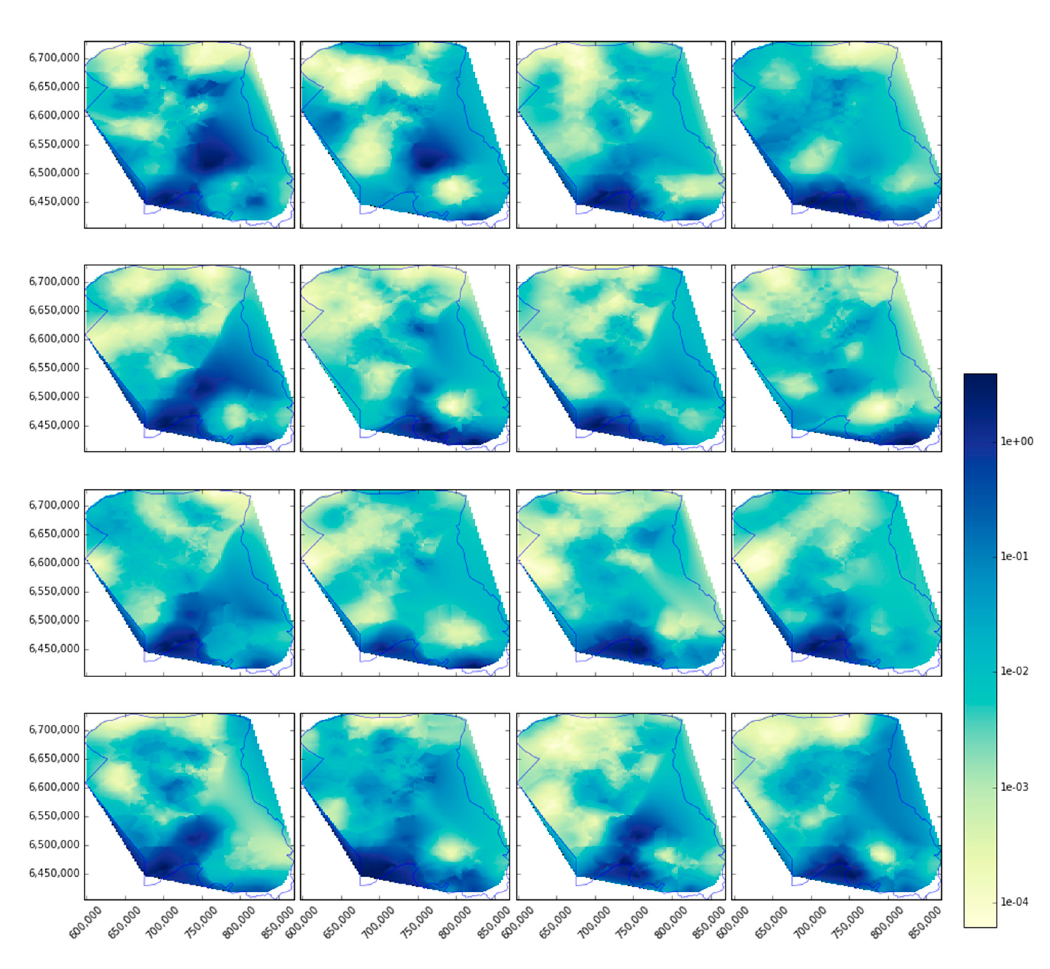
Figure 3. Examples of realizations of the hydraulic conductivity (m / day) for model layer 6 representing the Pilliga Sandstone from the highly parameterized modelling